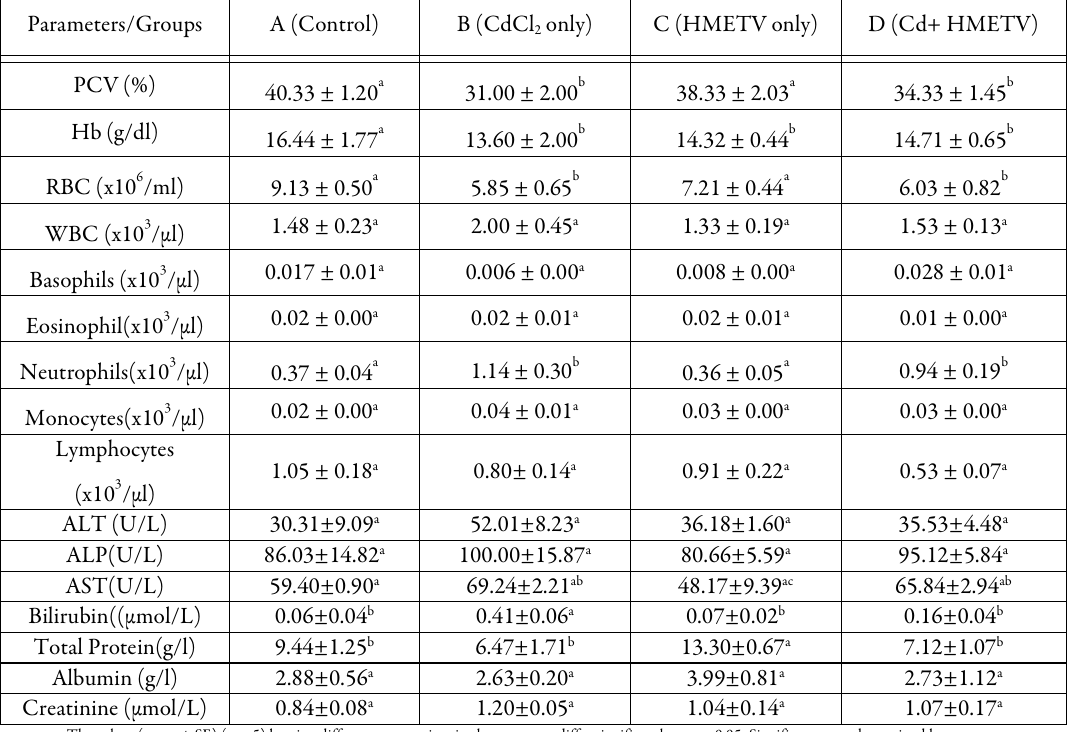
Table1. Hematological and serum biochemical parameters (mean ± SEM) of the experimental groups of